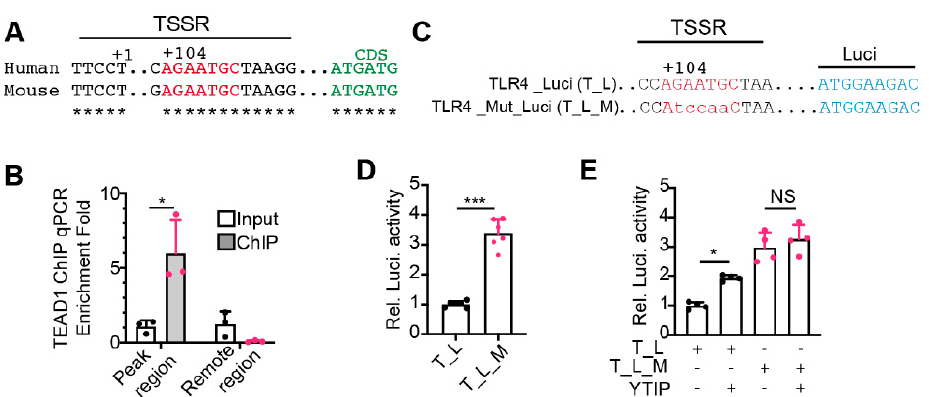
Figure 5. YAP/TEAD1 complex directly suppresses Tlr4 expression. ( A ). Schematic view of the transcription start site (TSS, +1) regions of human and mouse TLR4 genes. The conserved TEAD1 binding motif was depicted with red letters, and the TLR4 coding sequences were indicated with green letters. ( B ). TEAD1 ChIP qPCR. A primer set spanning the mouse Tlr4 TSS region was used to amplify ChIP products. Another primer set amplifying one fragment 2.5 kb away from the TSS was used as a negative control. Amplicon values from TEAD1 ChIP products were normalized with that of the input. n = 3. Student t-test, *, p < 0.05. ( C ). Depiction of the luciferase reporter constructs. TLR4_Luci (T_L) reporter contains the human TLR4 promoter driving luciferase. A conserved TEAD1 binding motif in the TLR4 promoter was mutated to generate TLR4_Mut_Luci (T_L_M). ( D , E ). Dual-luciferase reporter assay in HEK293T cells. Dual-luciferase assay was performed 24 h after transfection. YTIP: YAP and TEAD1 interference peptide. ( D ), student t -test, *, p < 0.05. E, One-way ANOVA post hoc Tukey’s multiple comparisons test, *, p < 0.05, ***, p < 0.001. ( D , E ), n = 4–6.